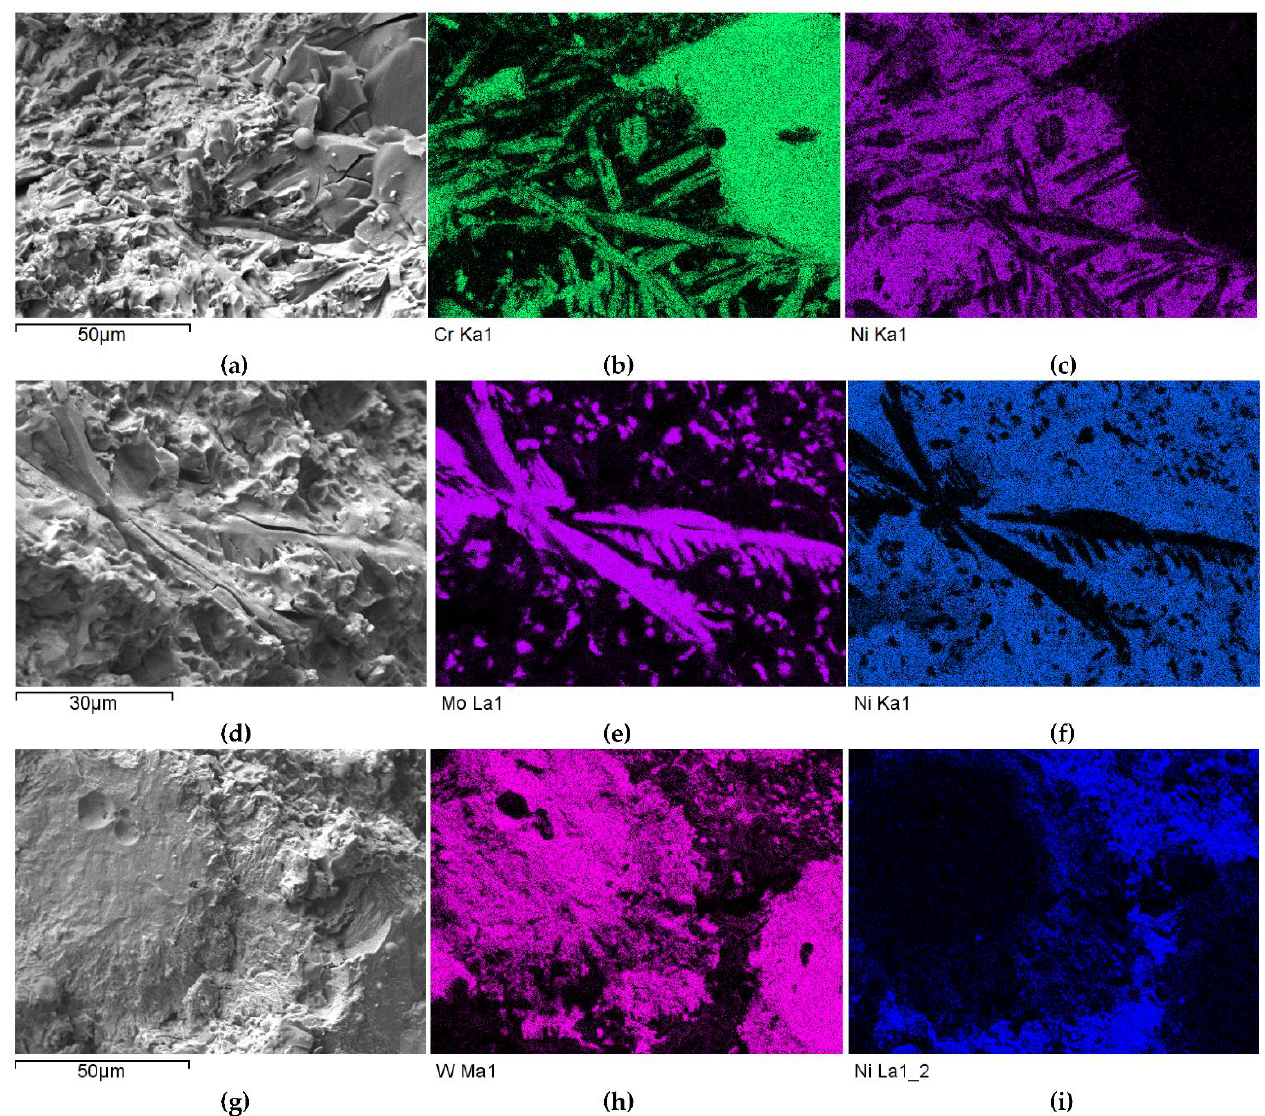
Figure 12. SEM/EDS micrographs of fractured surfaces of NiBSi–Cr 3 C 2 ( a – c ), NiBSi–Mo 2 C ( d – f ), and NiBSi–WC ( g – i ) composite welds enabling phases identification.